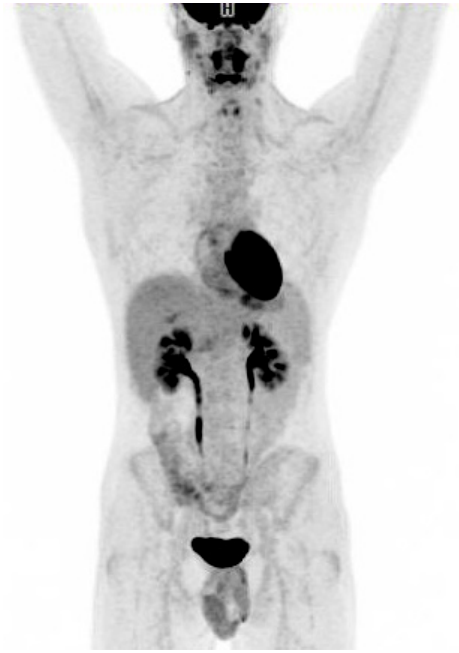
Figure 2. Additional diagnostic workup drawn a day prior to the 18 F-FDG PET/CT became available showing positive EBV VCA-IgM and negative EBV VCA-IgG indicating acute infectious mononucleosis. CMV-IgM was furthermore positive. HIV and hepatitis panels were negative.